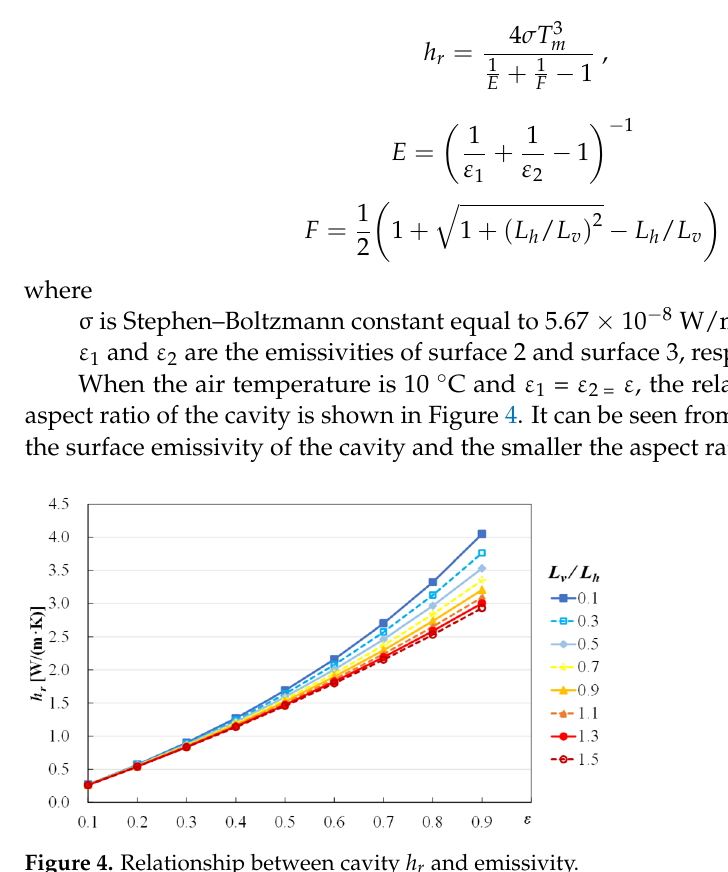
Figure 4. Relationship between cavity h r and emissivity.